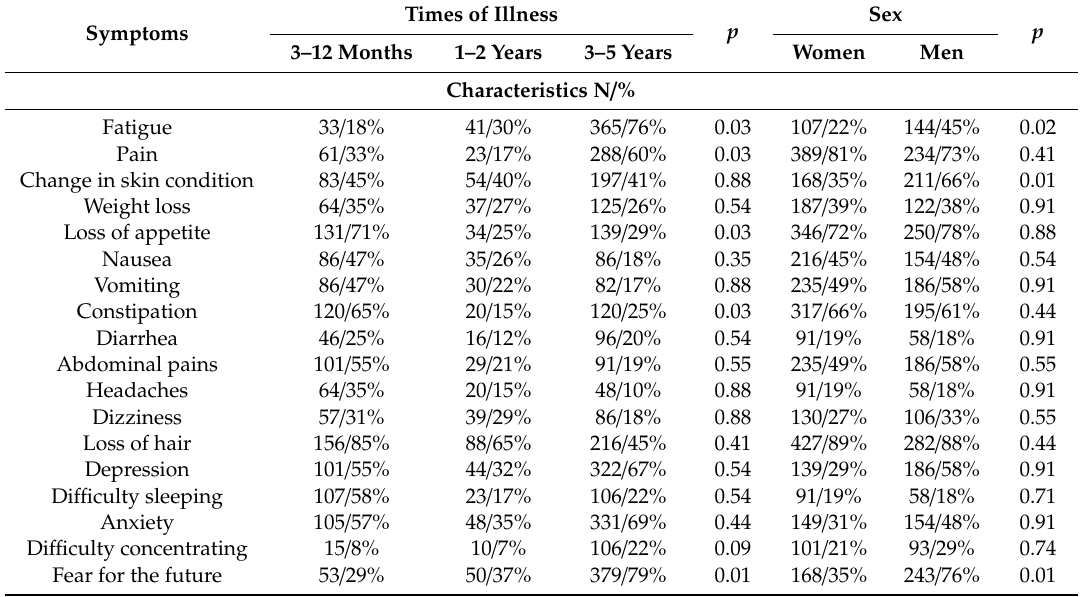
Table 2. Symptoms